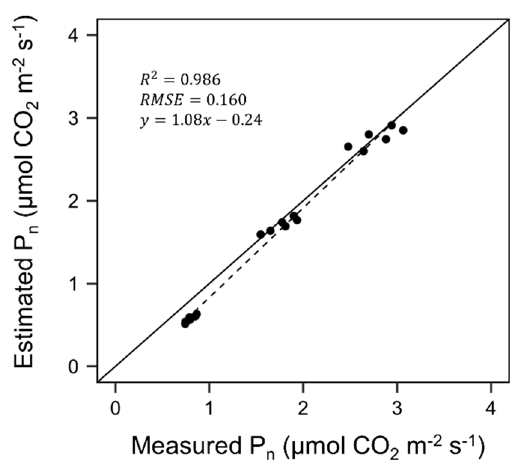
Figure 5. Comparison between measured and estimated canopy photosynthetic rates (P n ) in the growth chamber. The PPFD was set to 100, 200, and 300 µ mol m − 2 s − 1 , and the CO 2 concentration was set to 500, 600, and 700 µ mol mol − 1 . Nine lettuce plants at DAT 21 were used.